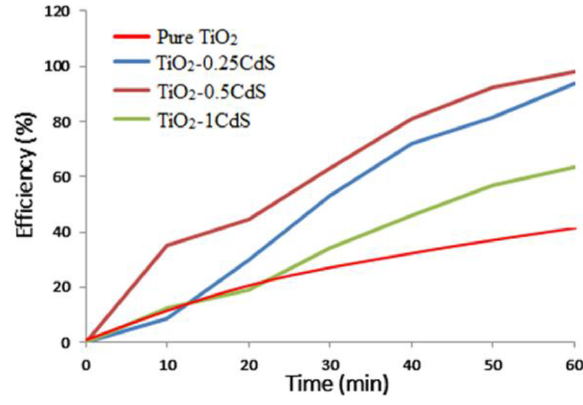
Figure 7: Eflciency of MB degradation using pure and composite TiO 2 with various CdS loadings.